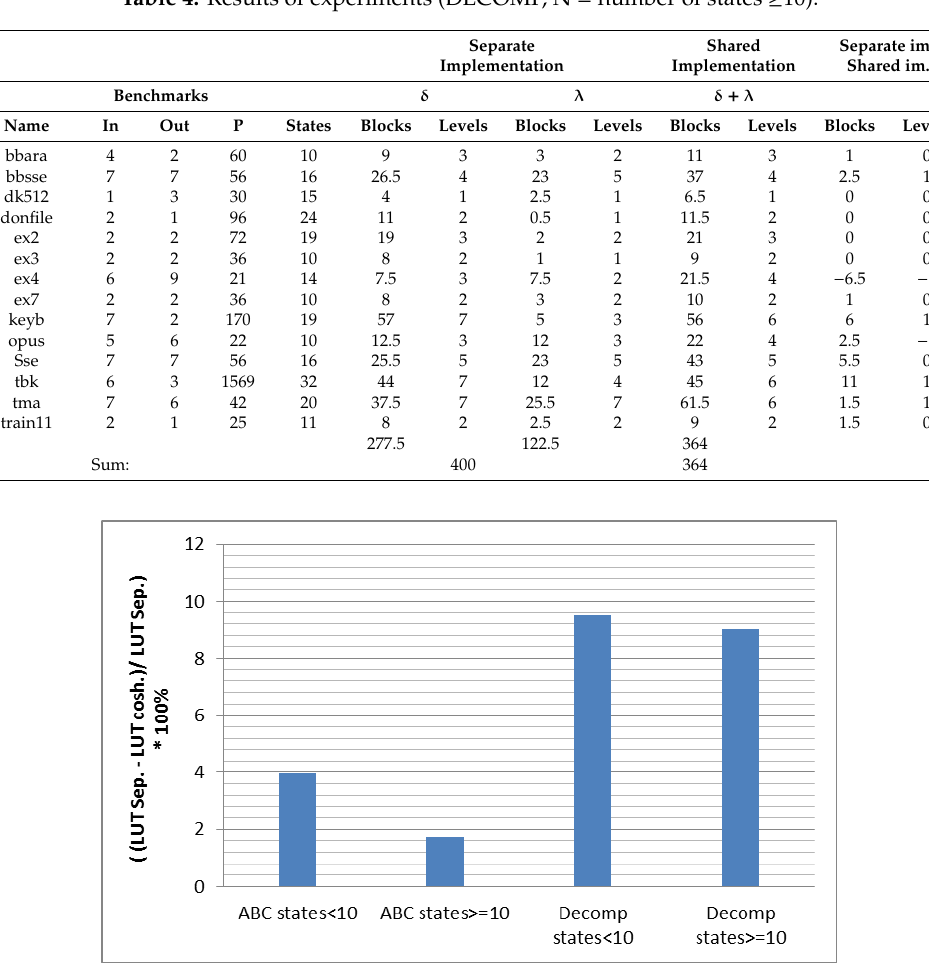
Table 4. Results of experiments (DECOMP, N = number of states ≥ 10).